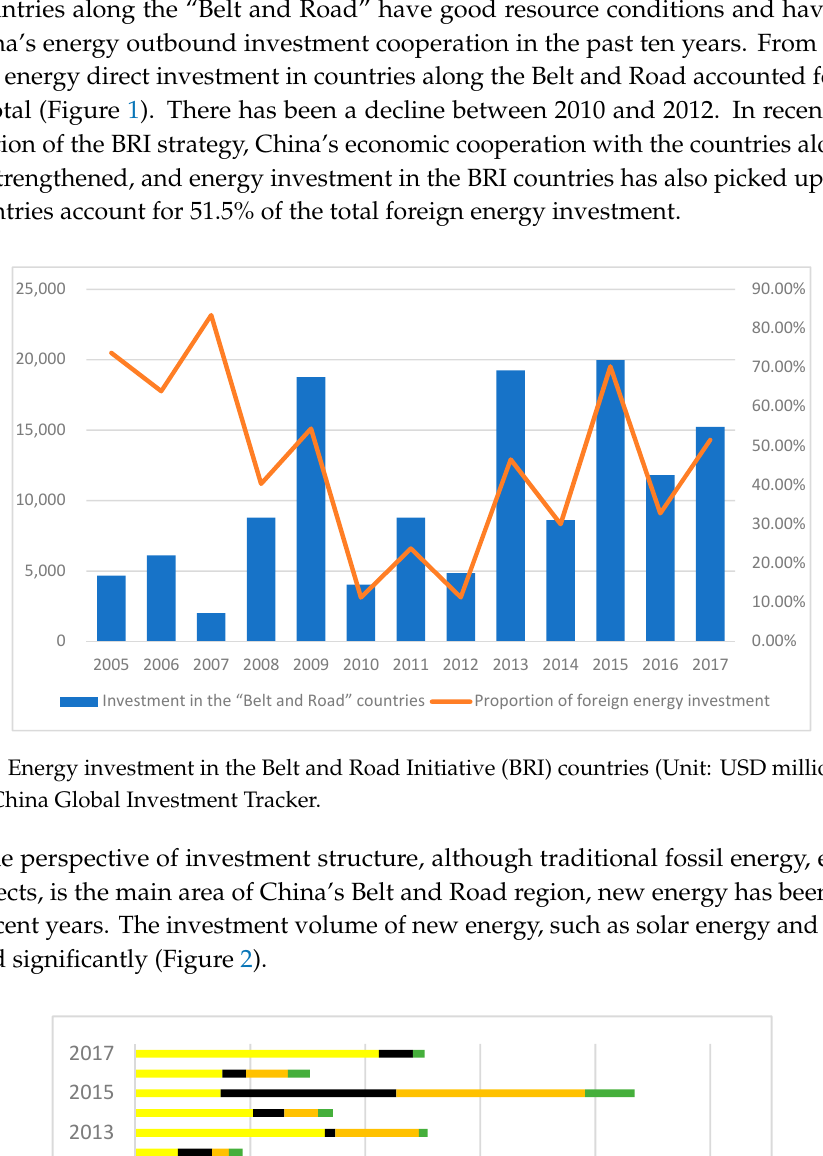
Figure 2. Investment structure in the BRI countries. Data source: China Global Investment Tracker.